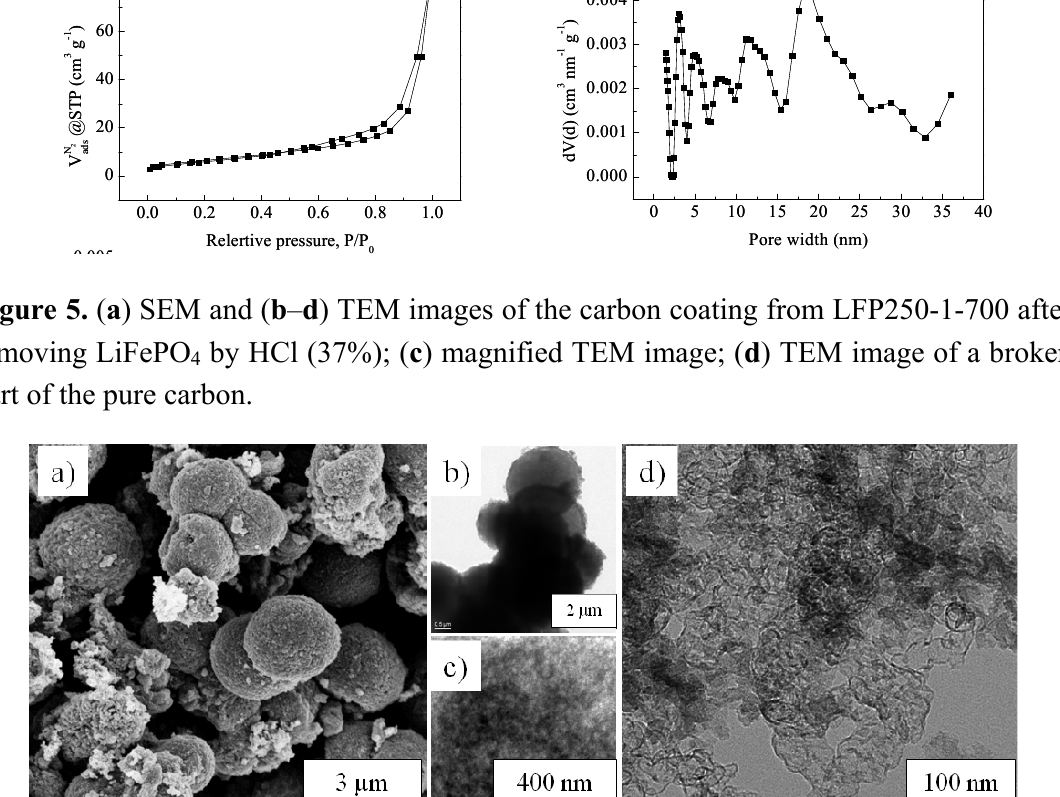
adsorption isotherm and ( b ) pore size 2